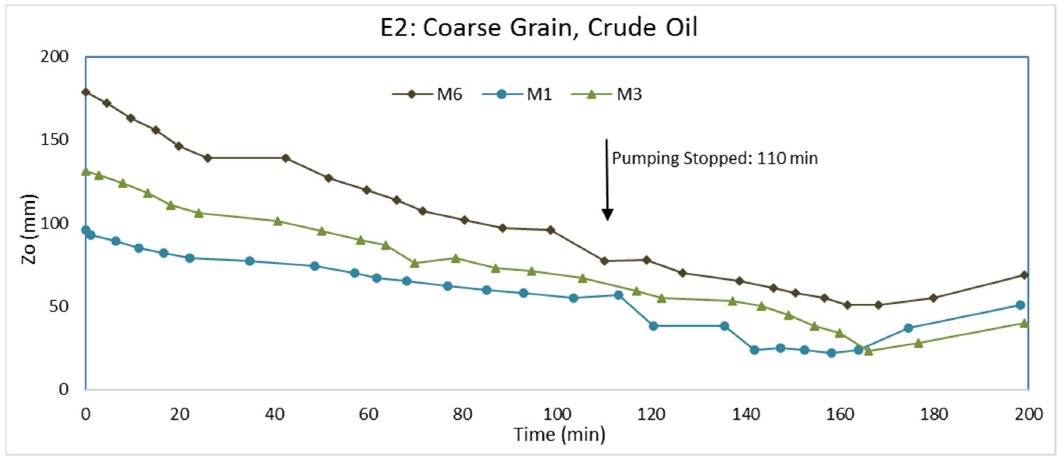
Figure 7. LNAPL thickness (Zo) variations in monitoring wells for E2.